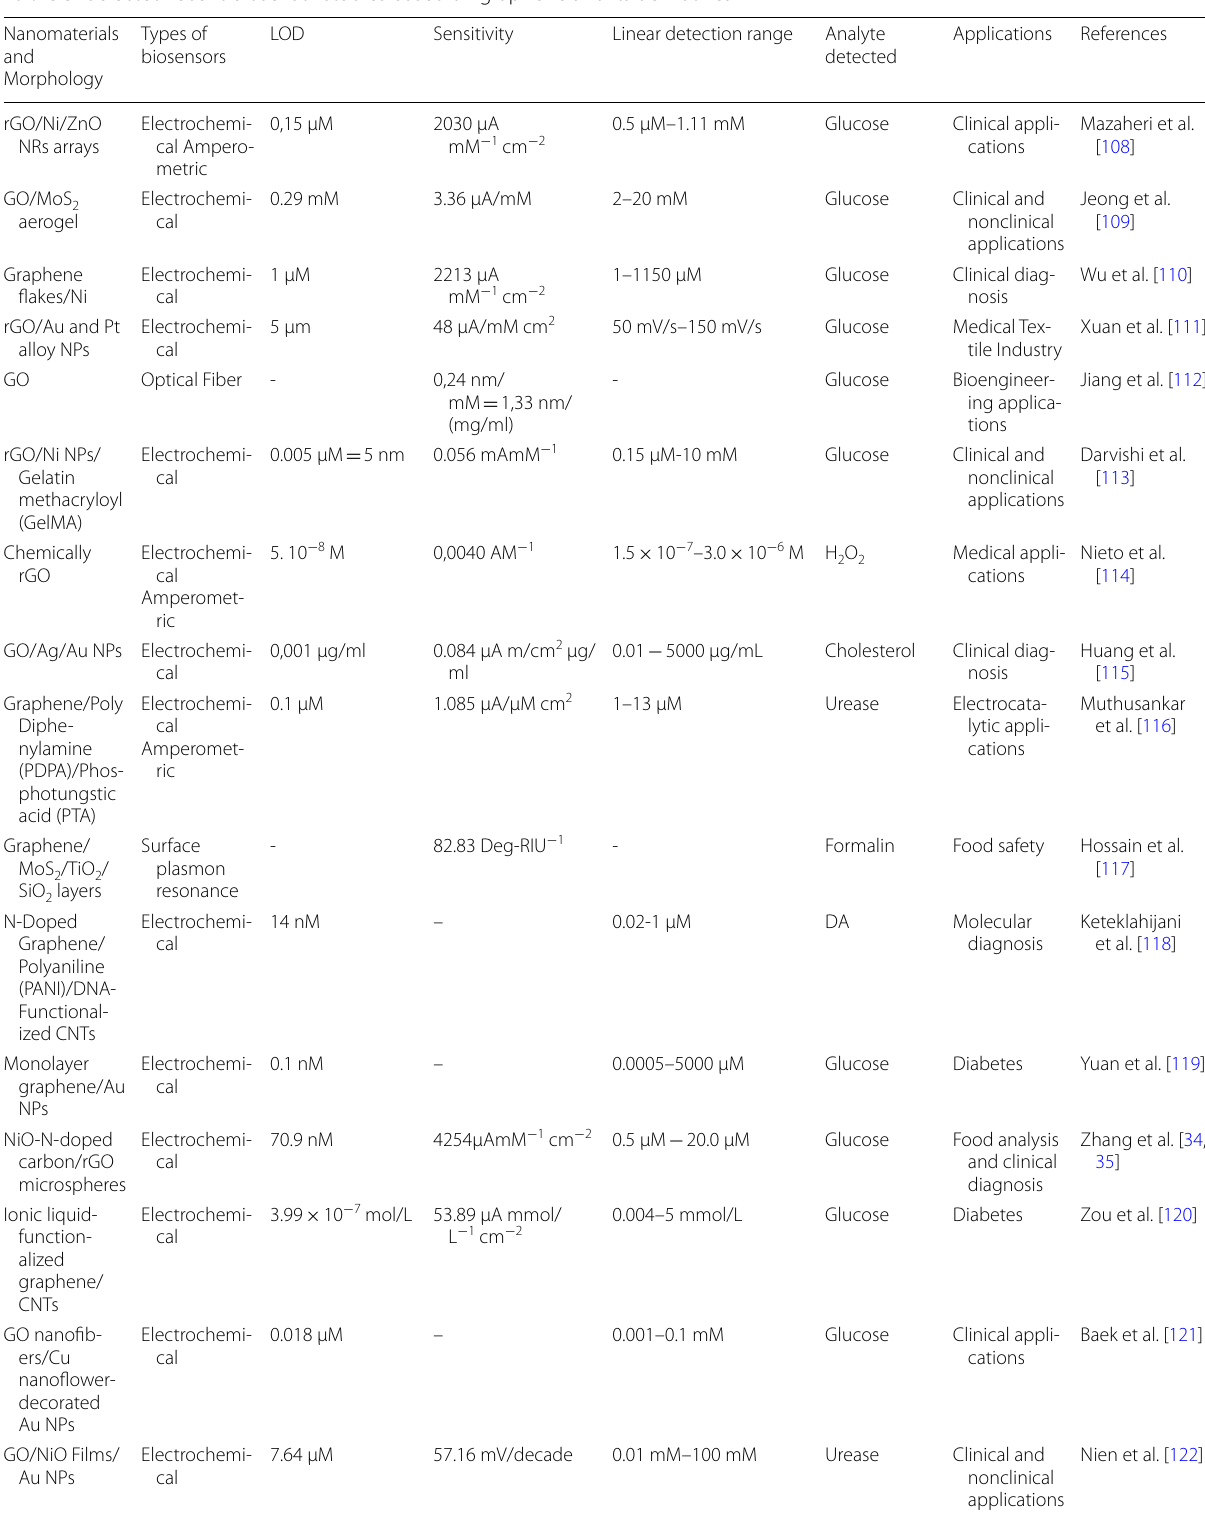
Table 3 Selected recent biosensor studies based on graphene and its derivatives Nanomaterials and